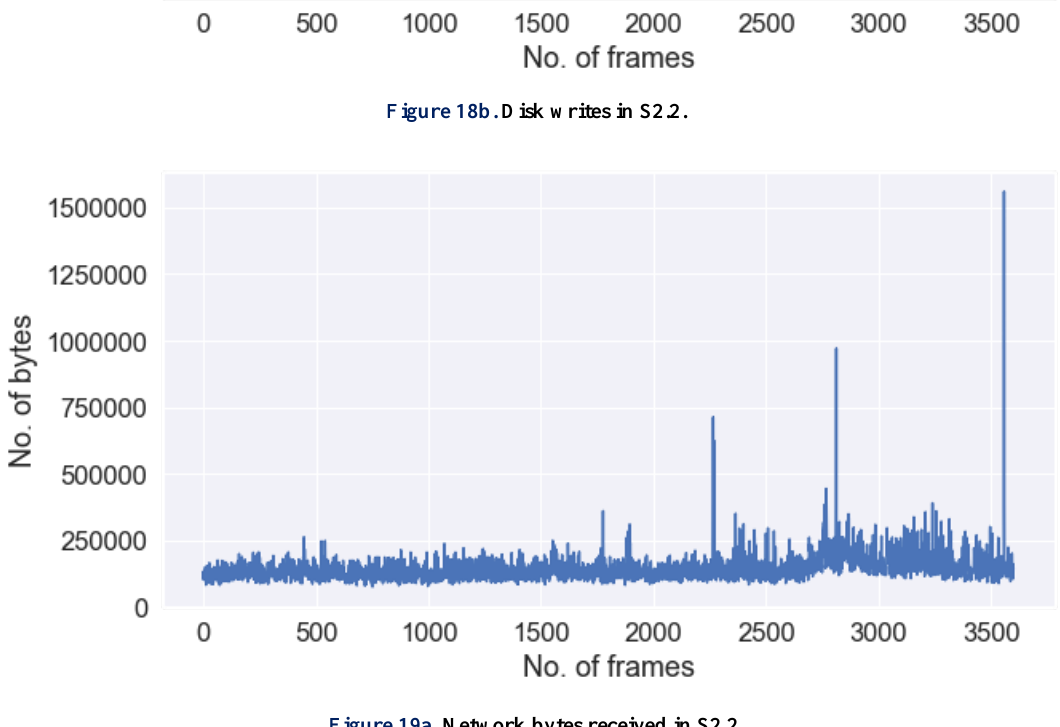
Figure 19a. Network bytes received in S2.2.